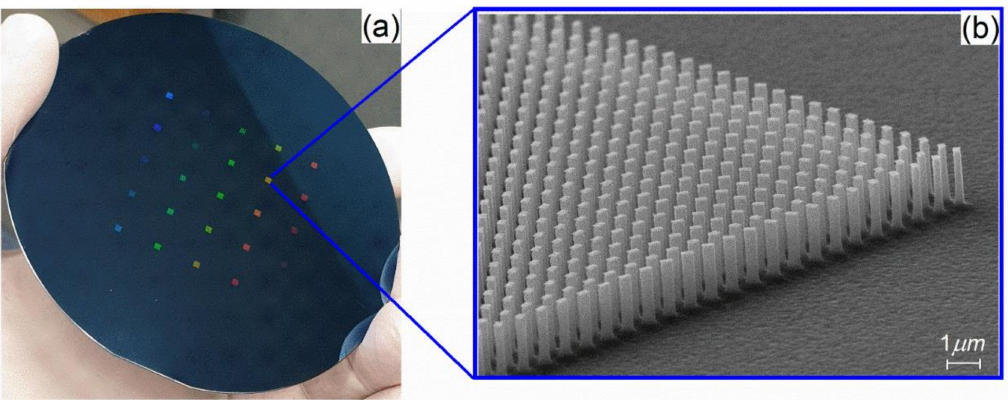
Figure 6. ( a ) Four inches Si master wafer containing nanopatterned metasurfaces via e-beam lithography and cryogenic etching method; ( b ) detail of the metasurface area containing silicon rectangular nanopillars with straight profiles and smooth